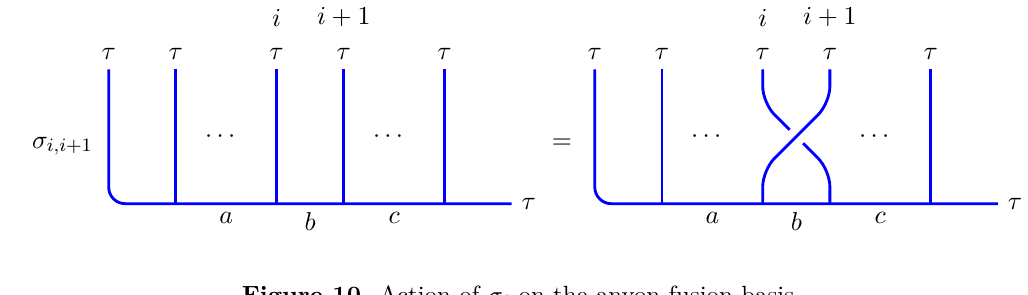
Figure 10 . Action of σ i on the anyon fusion basis.